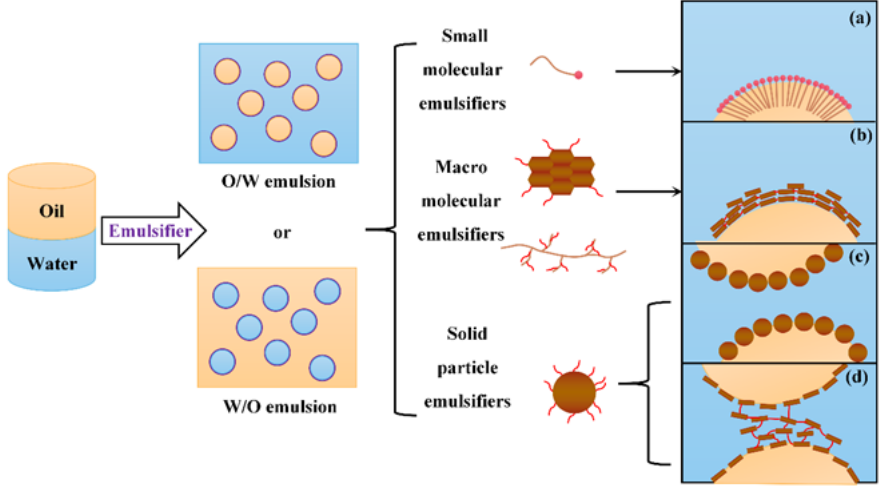
Figure 5. The morphologies of the interfacial film are stabilized by different emulsifiers, ( a ) small molecular emulsifiers, ( b ) macro molecular emulsifiers, ( c ) solid particles, ( d ) three-dimensional net structure.